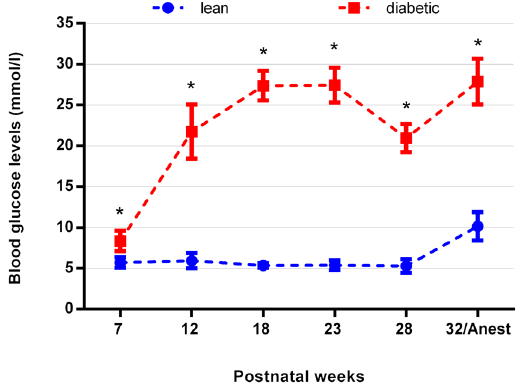
Figure 1. Blood glucose levels of lean and diabetic animals measured in different postnatal ages. From the 7 th week till the end of the observation period (time of anaesthesia, 32 nd week (32/Anest)) blood glucose levels were significantly higher in diabetic specimens compared to controls. * p <